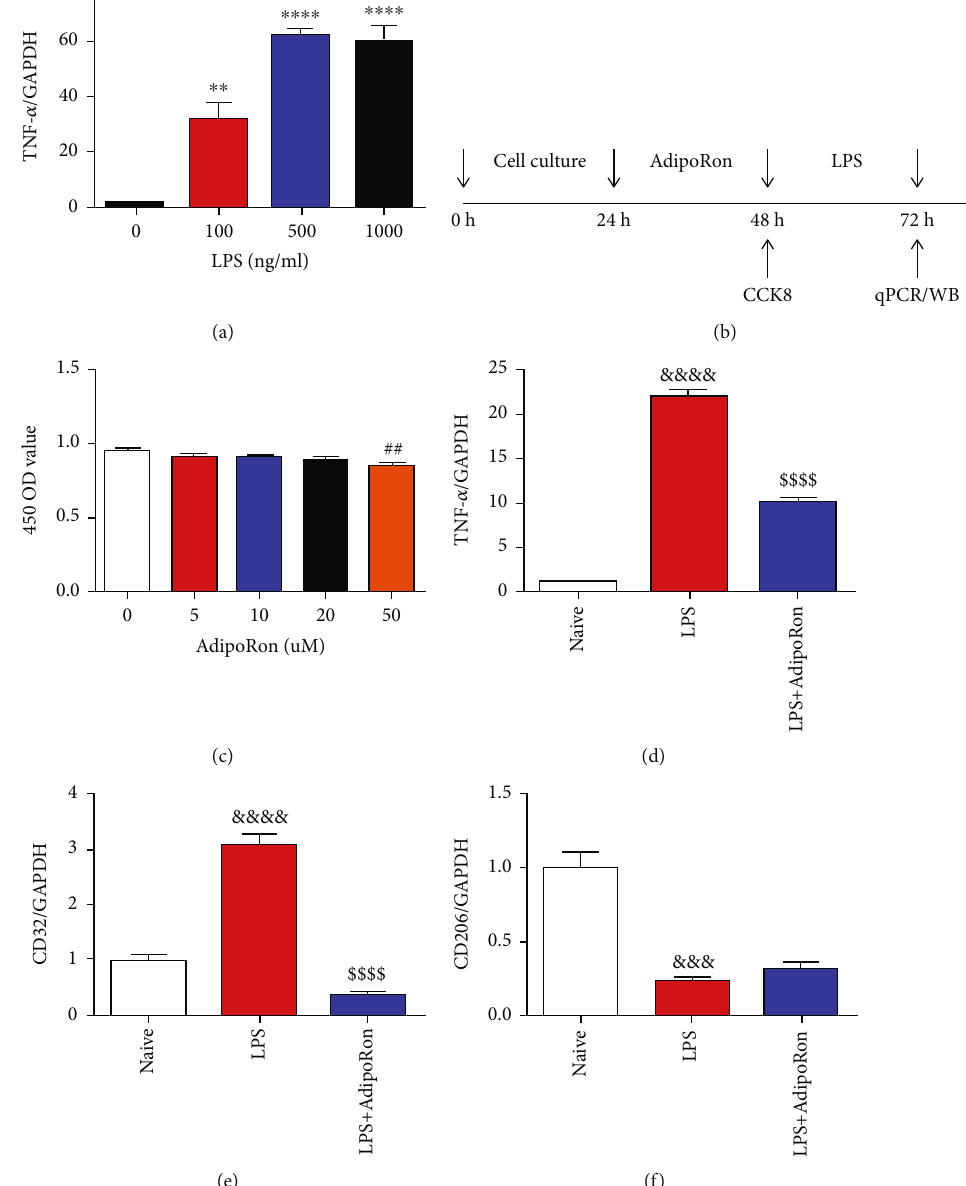
Figure 4: AdipoRon inhibited LPS-induced TNF- α expression in BV2 cells. (a) E ff ects of di ff erent concentrations of LPS on the expression of TNF- α in BV2 cells. (b) Timeline of in vitro experiments. (c) E ff ects of di ff erent concentrations of AdipoRon on the proliferation of BV2 cells. (d) AdipoRon at a concentration of 50 μ M inhibited the expression of TNF- α induced by LPS in BV2 cells. (e, f) E ff ects of AdipoRon at a concentration of 50 μ M on the LPS-induced polarization imbalance in BV2 cells. All results were presented as mean ± SEM ( n = 3 ). ∗∗ p < 0 : 01 , ∗∗∗ p < 0 : 001 , and ∗∗∗∗ p < 0 : 0001 vs. 0 ng/ml, ## p < 0 : 01 vs. 0 μ M, &&& p < 0 : 001 and &&&& p < 0 : 0001 vs. Naive, and $$$ p < 0 : 001 and $$$$ p < 0 : 0001 vs.